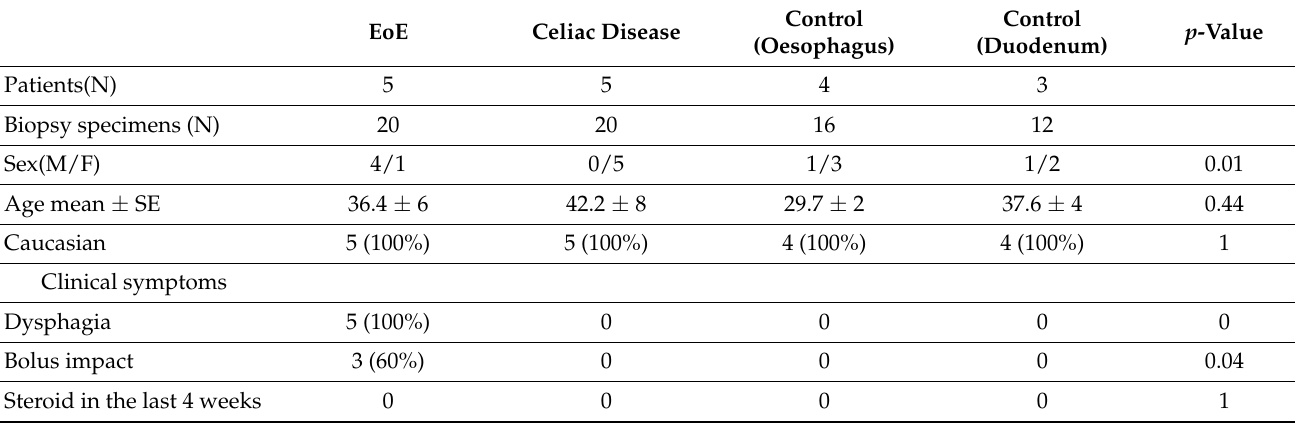
Control (Oesophagus)